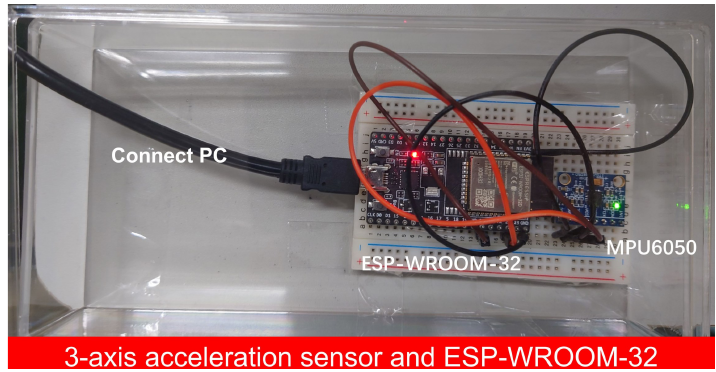
Figure 8. The acceleration sensor system for reference.